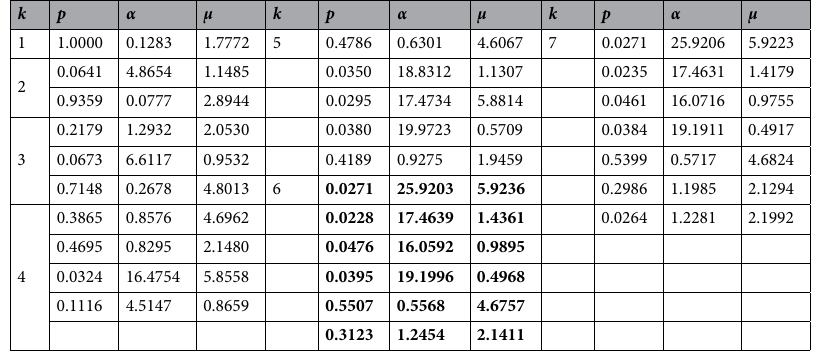
Table 6. Parameter estimation results for circular variable between the wind speed and direction using different voM mixture distributions. There are 17 unknown parameters need to be estimated totally. The results of the best model are in